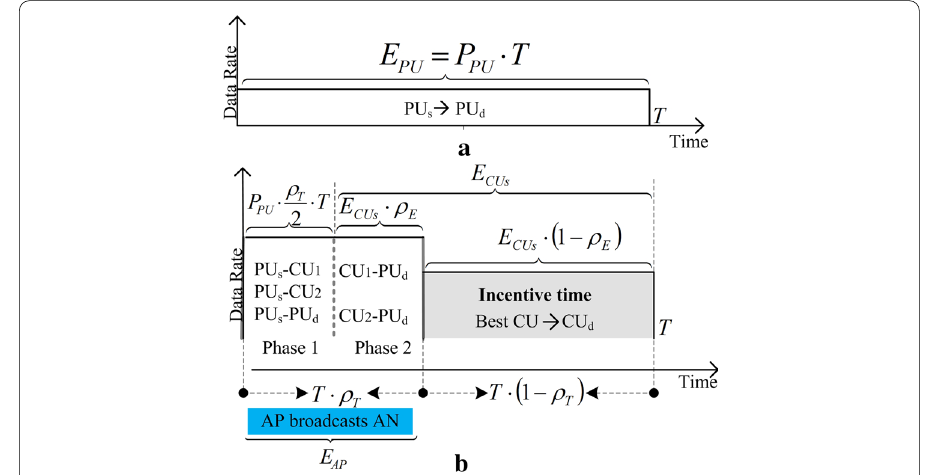
Fig. 2 Transmission methods for CCR and